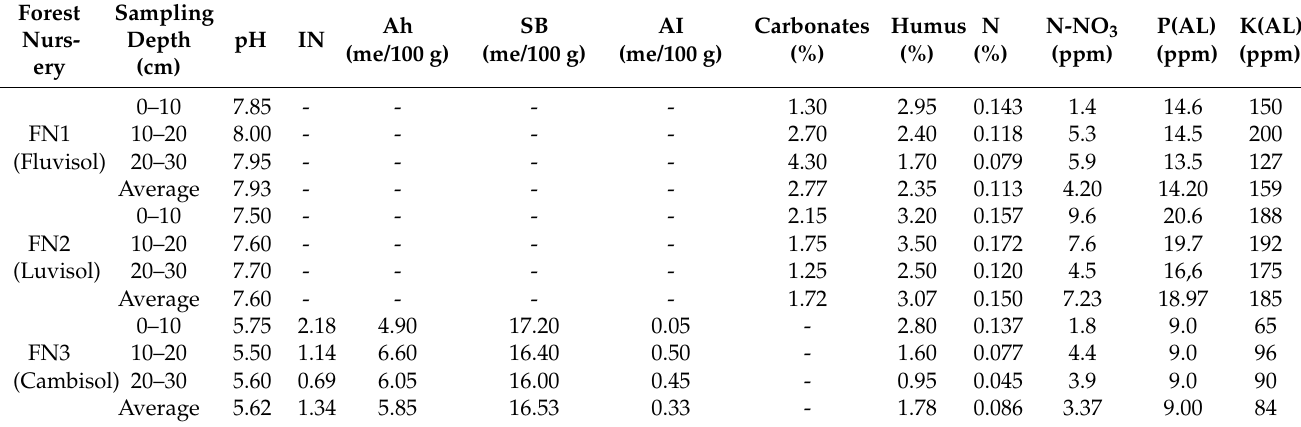
Table A2. Results of the analysis on chemical properties of the